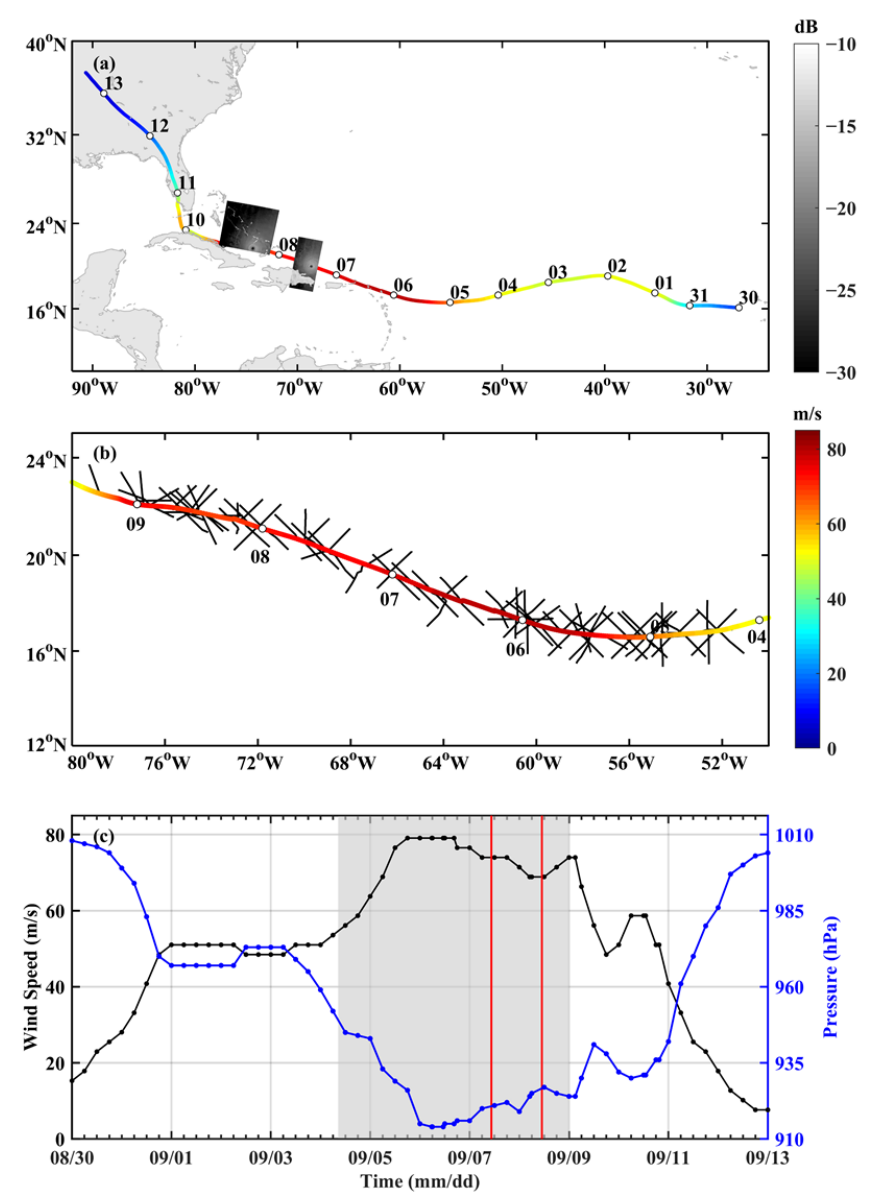
Figure 1. ( a ) SAR images over Hurricane Irma (2017) with respect to the best track. The color bars denote σ 0 (unit: dB) of the VH-polarization SAR image. RADARSAT-2 Data and Products MacDonald, Dettwiler, and Associates Ltd. (2008 – 2009). ( b ) The geolocations of 116 radial legs from September 4 to 8, 2017. The color bar (unit: m/s) denotes the intensity of Irma from the Best Track estimates. ( c ) The evolution of maximum sustained 10 − m winds (m/s; black line) and minimum surface pressure (hPa; blue line) associated with Hurricane Irma (2017). The periods of aircraft observations are shaded in gray. The red vertical lines depict the acquisition times of SAR images.